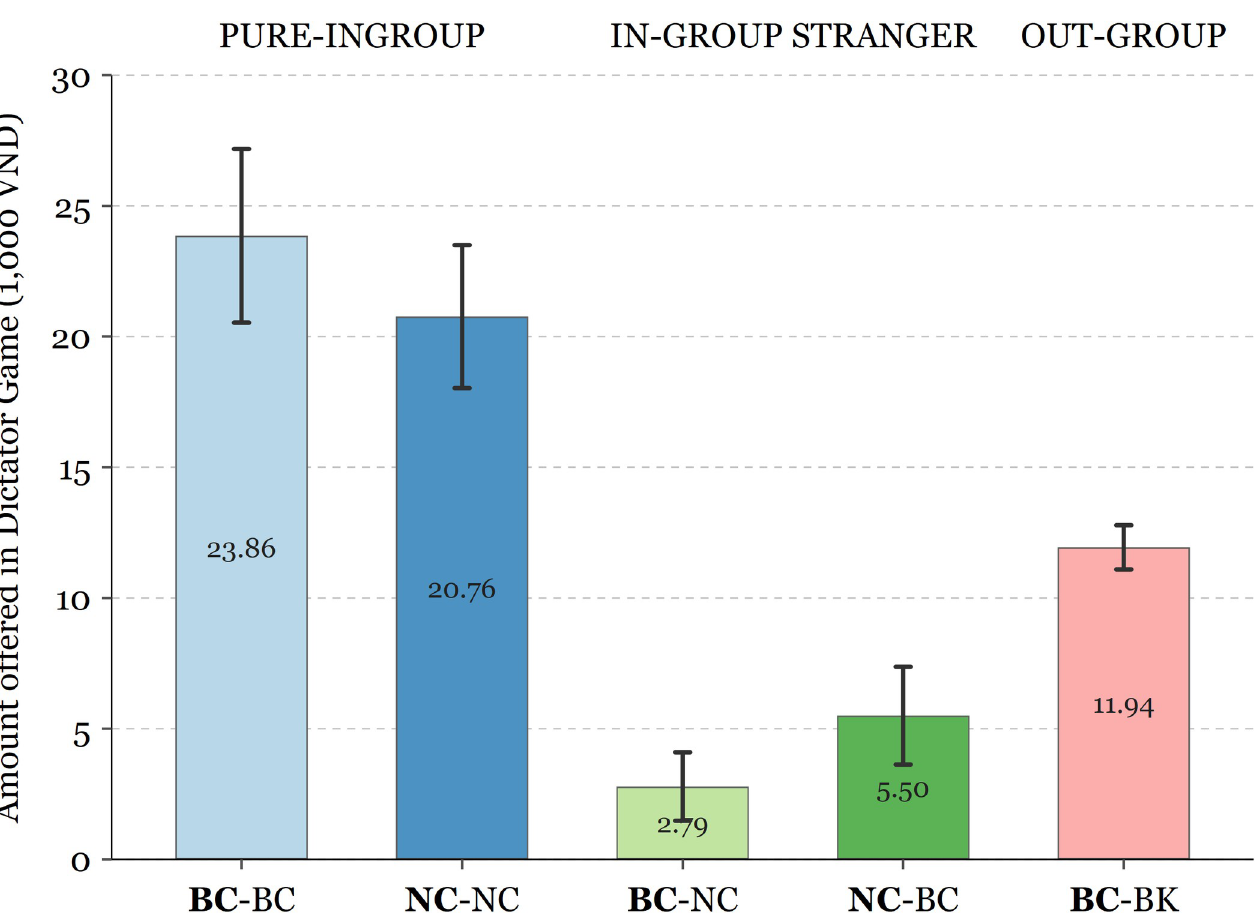
Fig 1. Amount offered in Dictator Game by treatment and session. Bar height indicates the average amount offered to Player 2. Error bars represent 95% confidence intervals. Sender (Player 1) in bold.